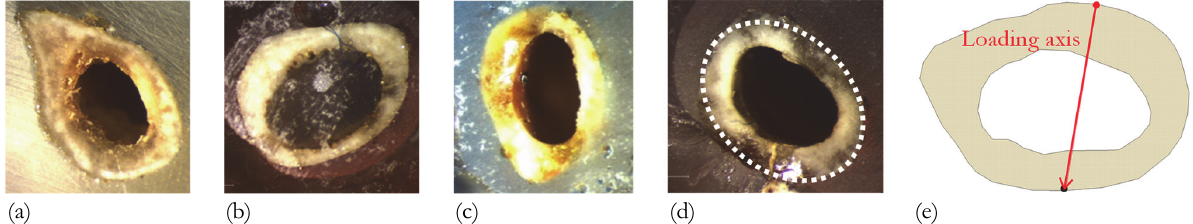
Figure 2: (a-c) Typical cross-sections of the bones tested; (d) The approximation of the cross-section using an ellipse; (e) The loading axis as it was determined for a typical cross-section of a femur.